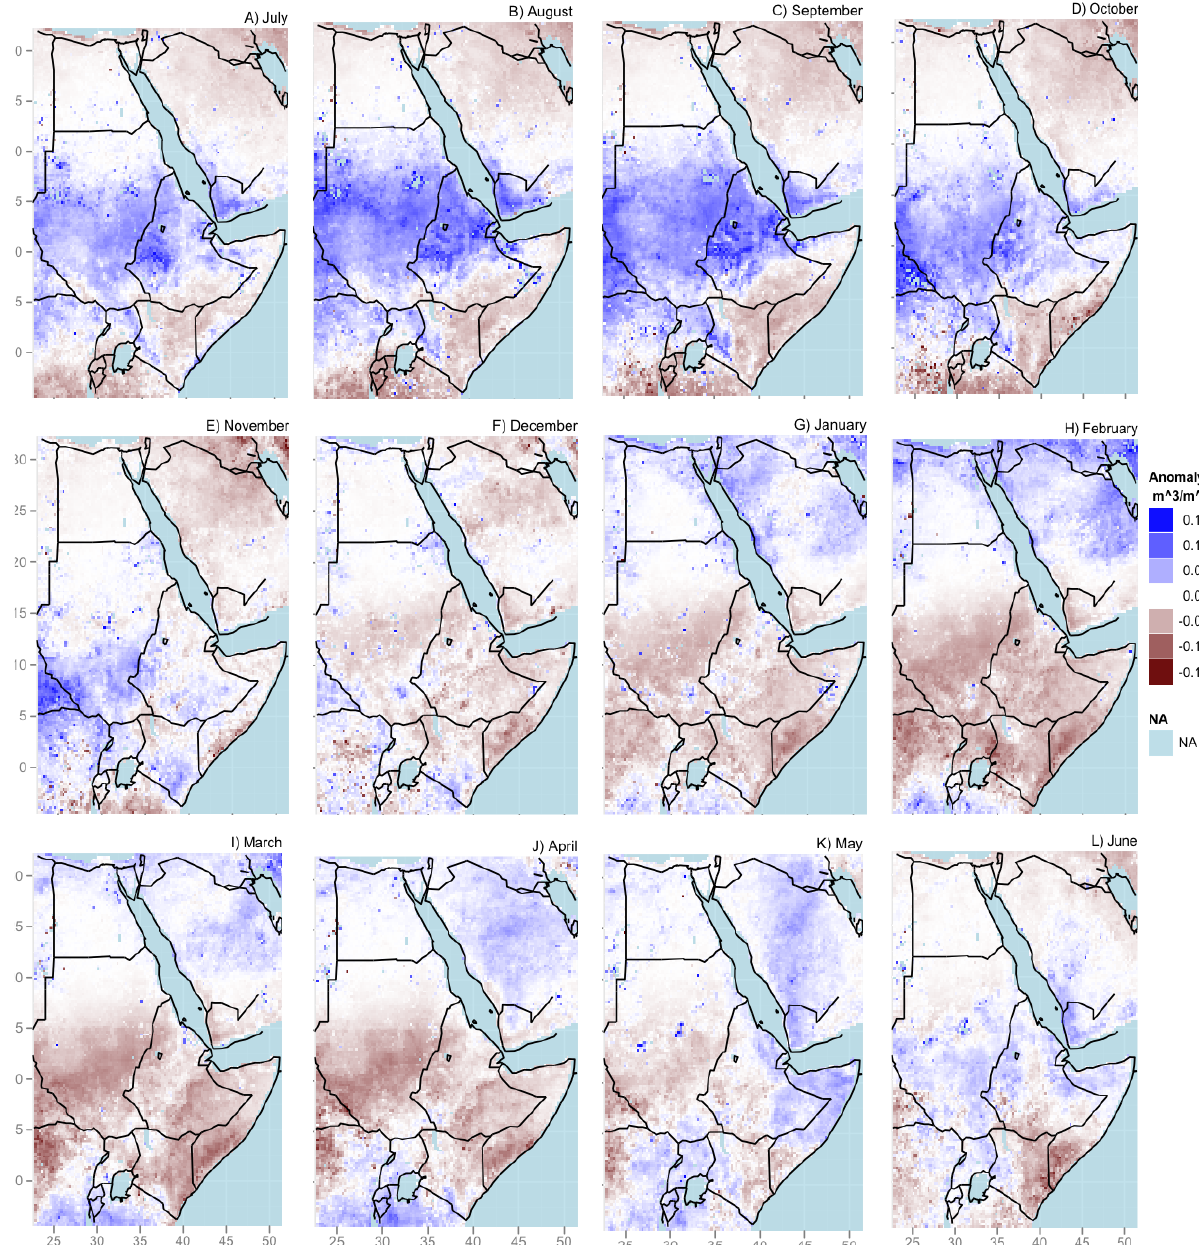
Fig. 11. Monthly anomaly maps of the progression of the 2010–2011 drought using the merged product. July–December 2010 (A–F) and January–June 2011 (G–L)